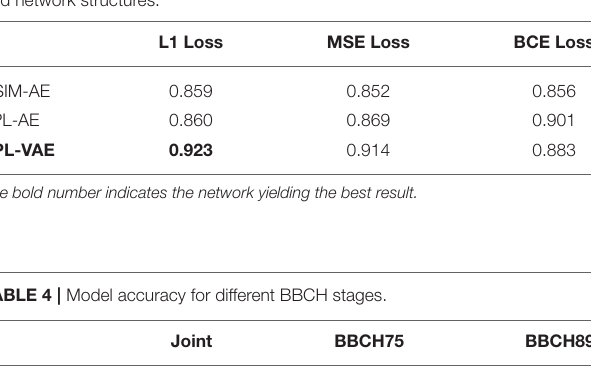
FIGURE 7 | Results for pixel-wise anomaly detection obtained by an FPL-VAE for damaged patches. The original images are displayed in the upper row. A corresponding heatmap of loss values is displayed in the middle, red color represents anomalies, and dark blue indicates non-anomalies. The darker the color, the more certain the network is, that a berry is damaged or healthy. In the third row, the red color highlights the manual annotations of anomalous berry regions.